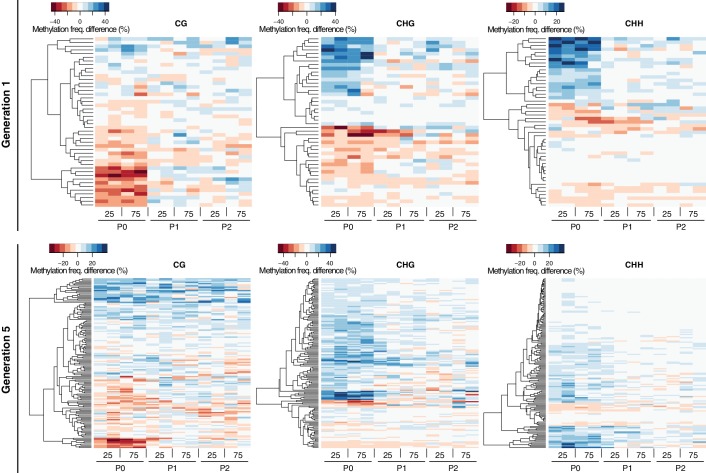
Methylation dynamics of HS-DMRs across three generations.One-directional clustering of DMRs in generations 1 and 5 by methylation frequency difference, divided by sequence context. Methylation frequency differences were calculated by subtracting the methylation frequency for each DMR in the respective sample from the average methylation frequency in the combined P0, P1 and P2 control samples. Blue colour indicates hyper-, red colour indicates hypo-methylation. C, control; 25, 25 mM NaCl; 75, 5 mM NaCl.